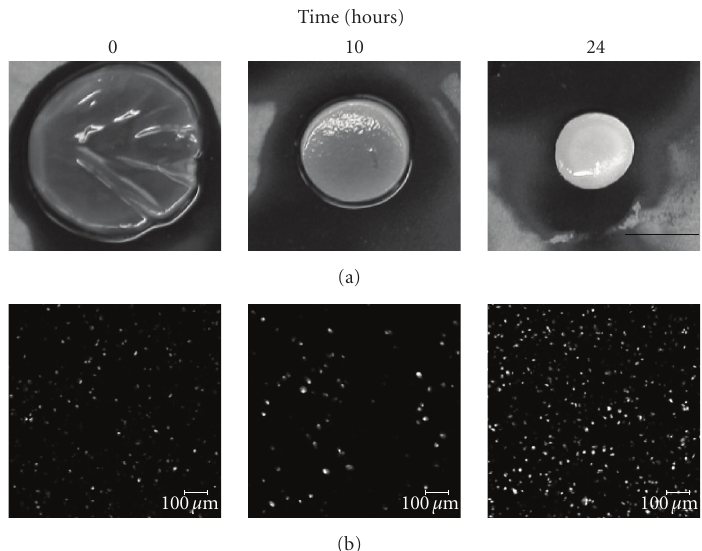
Figure 3: Changes in cell density alter compaction and nuclear organization. hMSC at a cell density of 1 × 10 6 cells/mL embedded in 2mg/mL collagen I gel. Collagen I gels were fixed and then stained for nuclei with SYTOX Green. (a) Macroscale images of hydrogel compaction (Scale bar = 1cm). (b) Fluorescent image cross section of hMSC nuclei (Scale bar = 100 μ m).